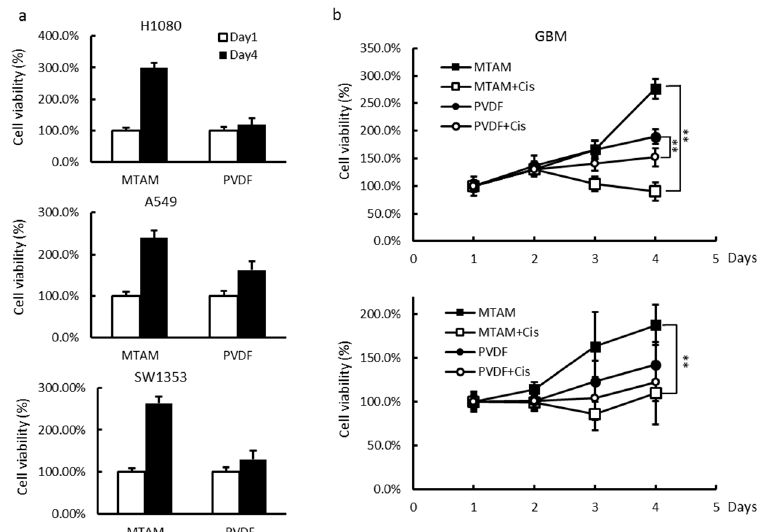
Figure 3. Comparison of cell growth rate and drug sensitivity between MTAM and PVDF HF. ( a ) H1080, A549 and SW1353 cells loading in MTAM or PVDF-HF at 1 × 10 6 cells/mL, were incubated at 37 ◦ C and retrieved at each time point. ( b ) Growth inhibition of GBM cells in the MTAM or PVDF-HF in growth medium (top right) or implanted s.c. in mice (bottom right). Drugs were administrated once daily by i.v. injection from days 3–7 after implantation. Student’s t-test; P < 0.05.